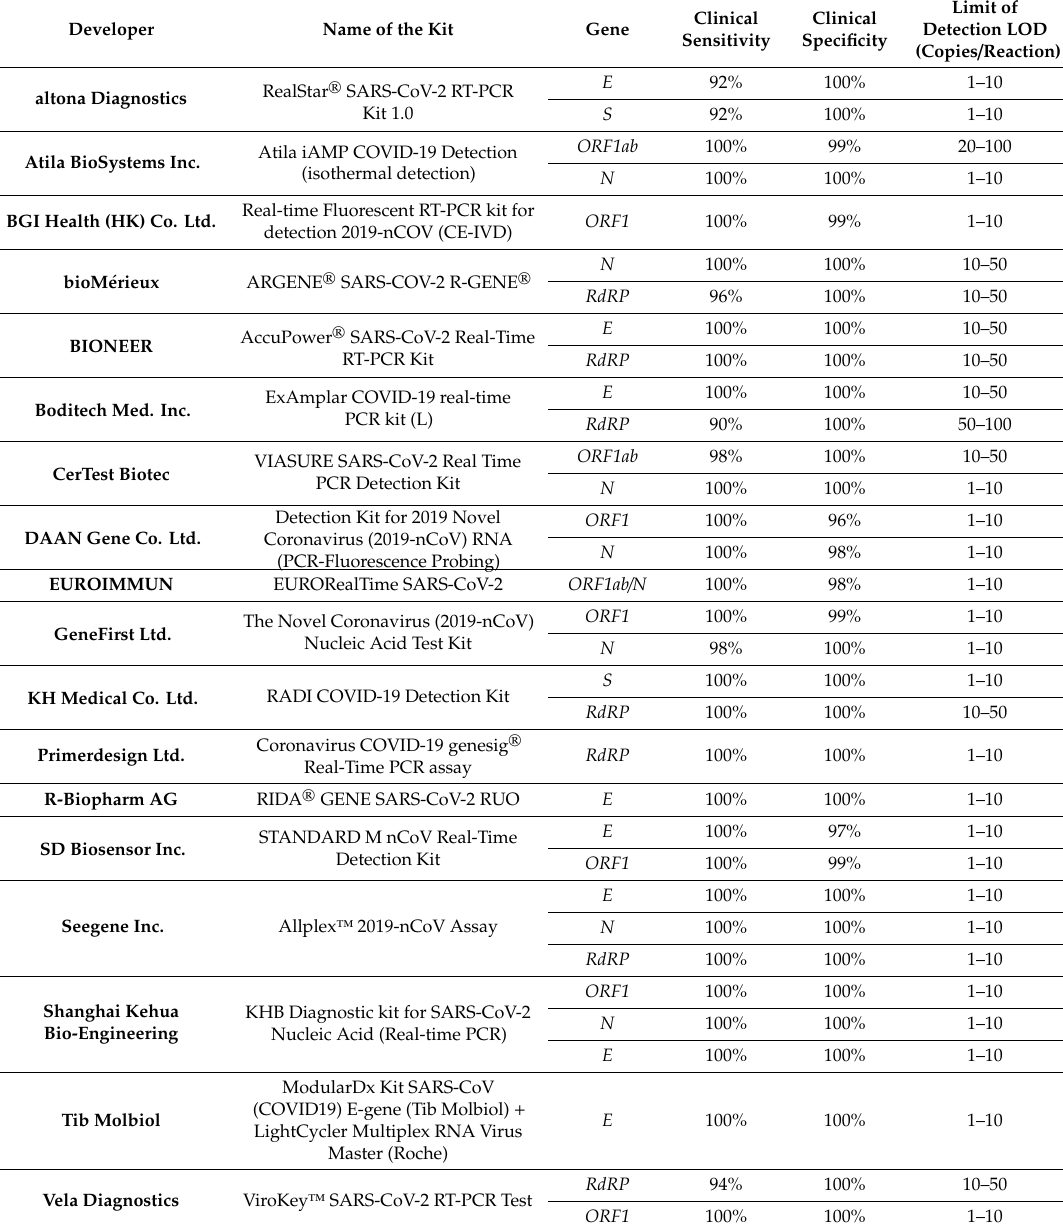
Table 2. The table shows results of independent evaluation to verify the clinical performance of tests. The research was carried out at the University Hospitals of Geneva [12] (updated 13 June 2020, online